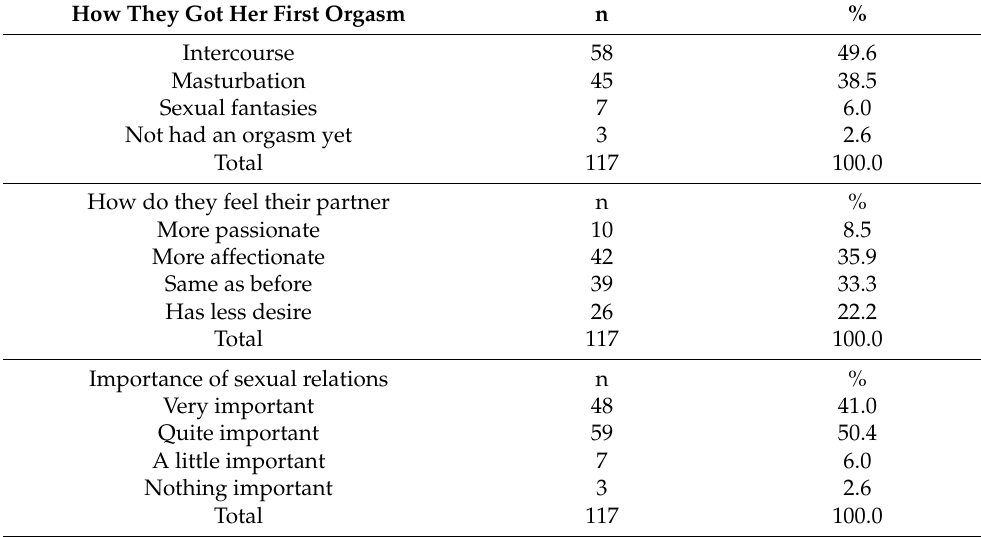
Table 7. Degree of satisfaction with